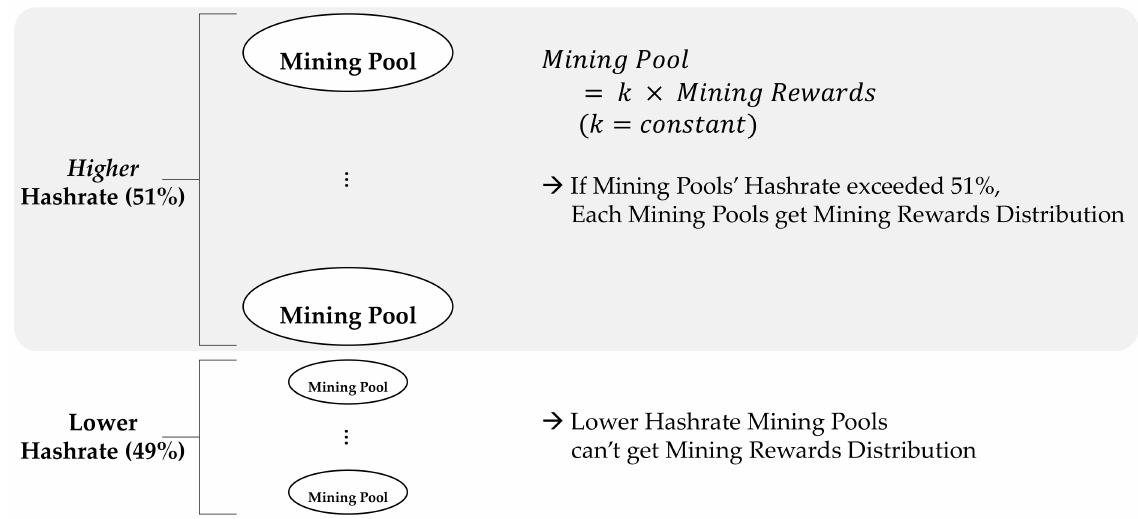
Figure 4. Proactive Approach for Double-Spending